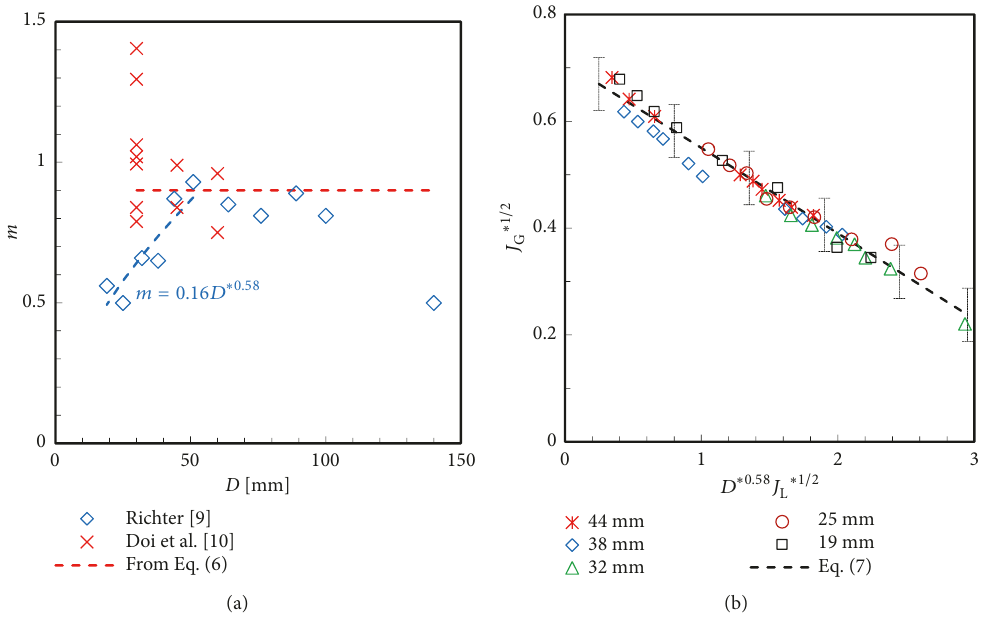
Figure 6: CCFL characteristics for small diameters with low water levels by Richter [9]: (a) slope m , and (b) CCFL.